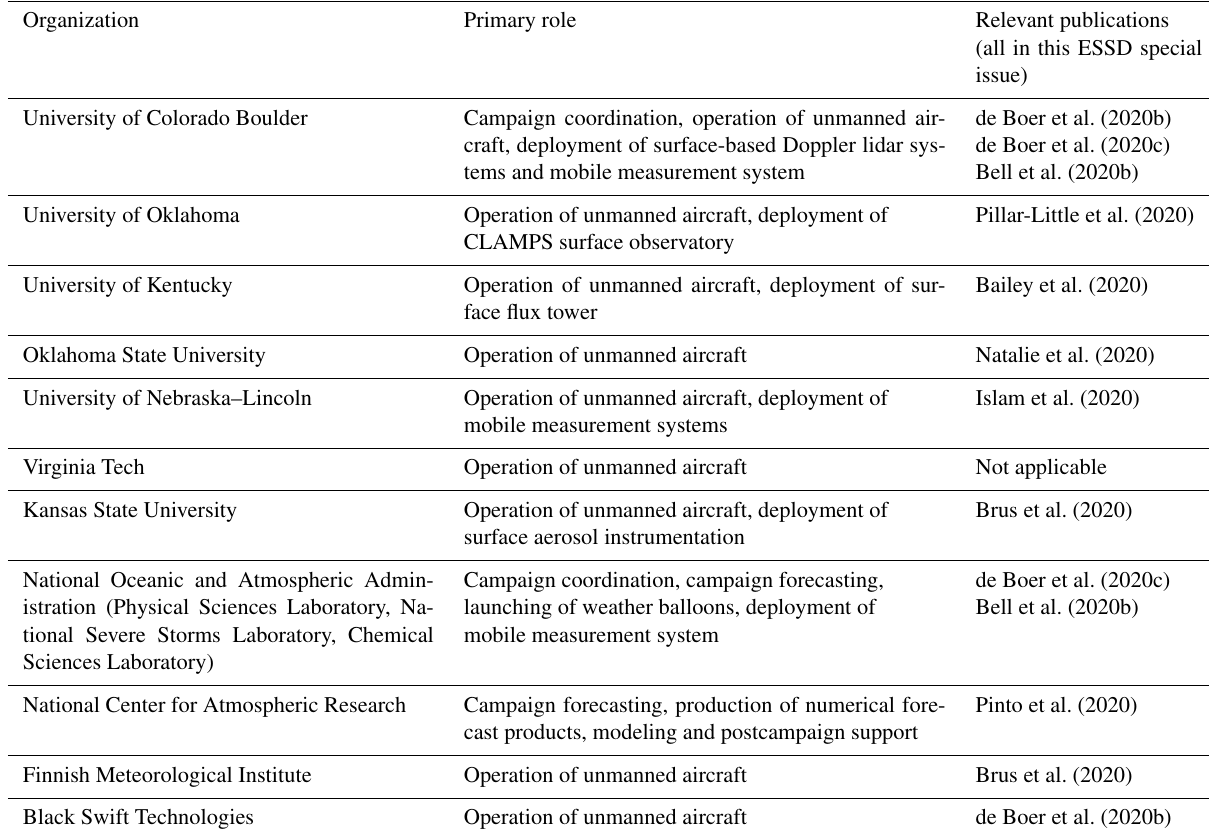
Table 1. A list of data-generating entities participating in LAPSE-RATE and the individual roles that each entity filled during the campaign.